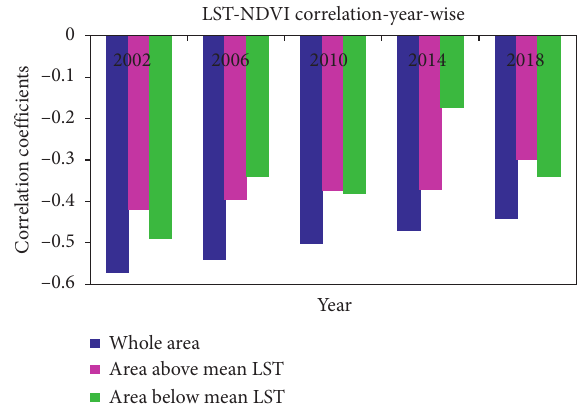
Figure 12: Year-wise LST-NDVI correlation